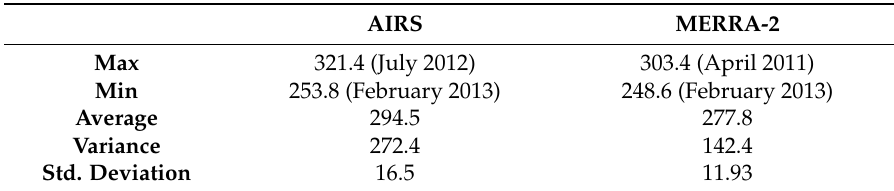
Figure 1. Temporal evolution of monthly average total ozone column over Egypt for the period (2005–2016) from AIRS and MERRA-2. Table 1. Basic descriptive statistics for monthly average total ozone column over Egypt for the period (2005–2016) from AIRS and